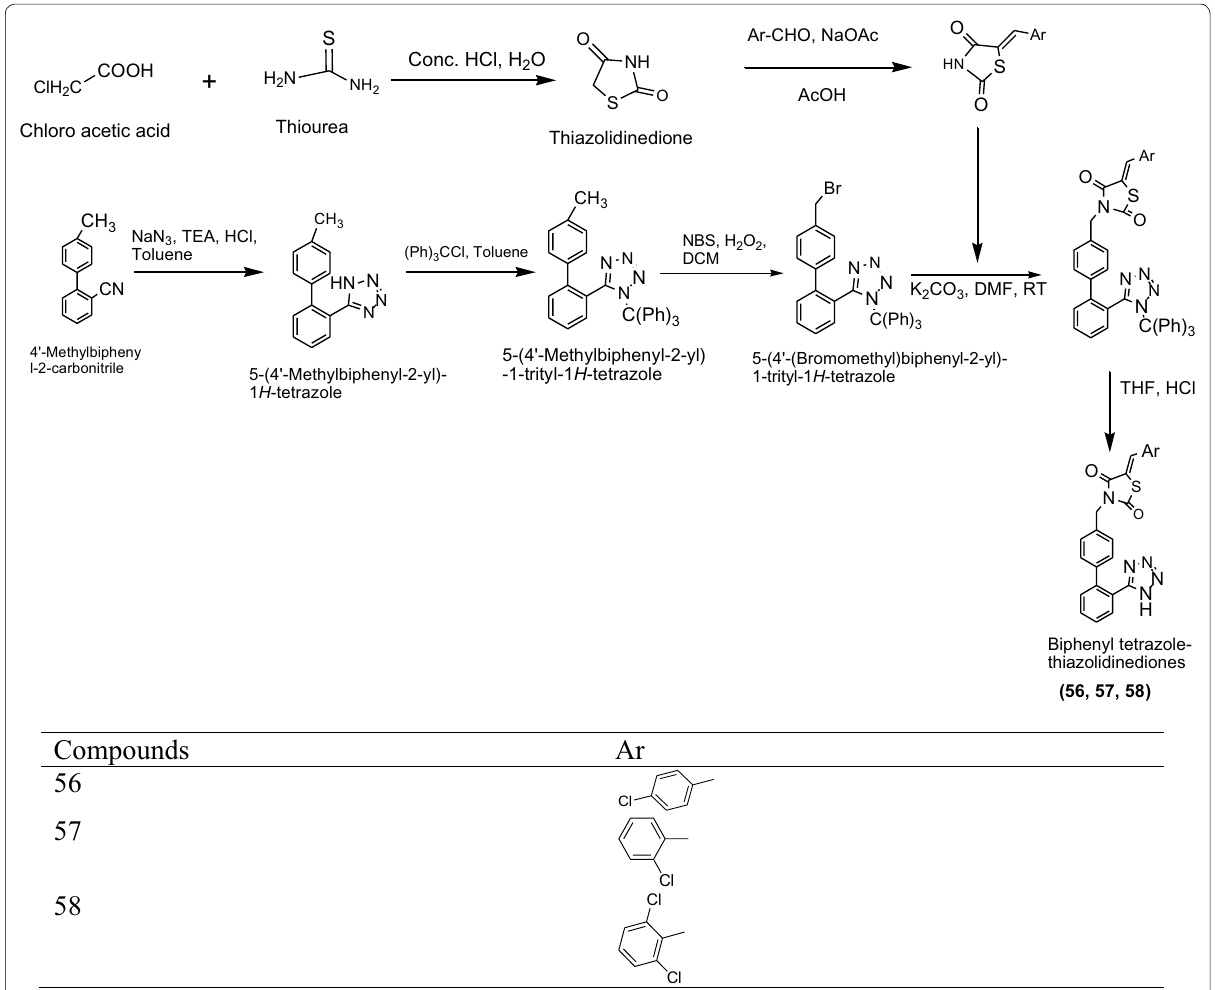
Scheme 18 Synthesis of Biphenyl tetrazole-thiazolidinediones Table 17 Antibacterial activities of synthesized